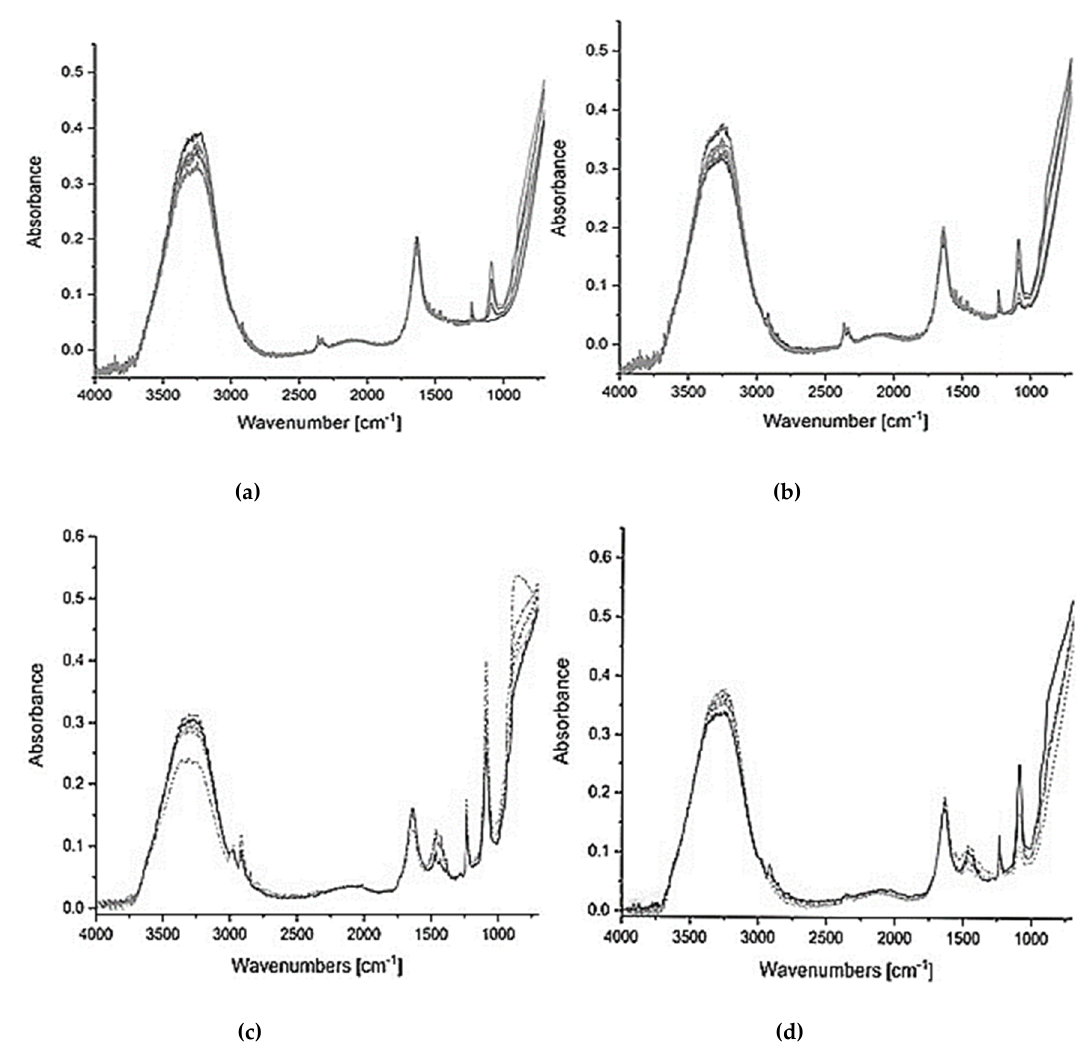
Figure 5. FTIR-AT spectra of deionized WST ( a ), deionized WTS ( c ), tap WST ( b ), and tap WTS ( d ). The spectra in the presented wavenumber region consisted of the bands at around 3250, 1600, 1200, and 1000 cm −1 . The band at ~3250 cm −1 was, in fact, an overlapped band belonging to asymmetric and symmetric stretching vibrations of the O-H groups of water ( OH ). The broad weak band around 2000 cm −1 was assigned to a combination band.